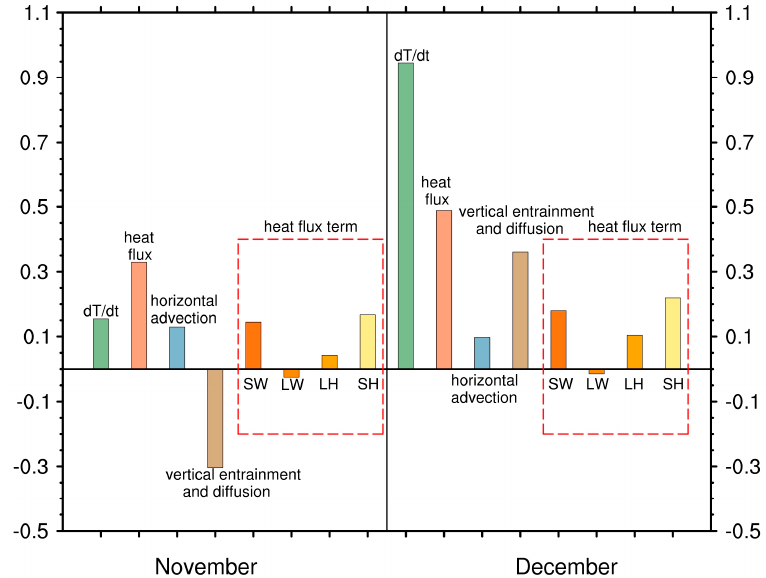
Figure 5. The heat budget (in °C/mon) of blob area in November and December of 2019. The “dT/dt” term is the tendency of SST (green bar), while the “heat flux” term (pink bar) is from atmosphere, “horizontal advection” term (blue bar), and “vertical entrainment and diffusion” term (brown bar) are calculated in the ocean mixed layer. In addition, the specific SW, LW, LH, SH terms are calculated and represented within the red-dashed box. All the heat flux terms are defined as positive downwards.